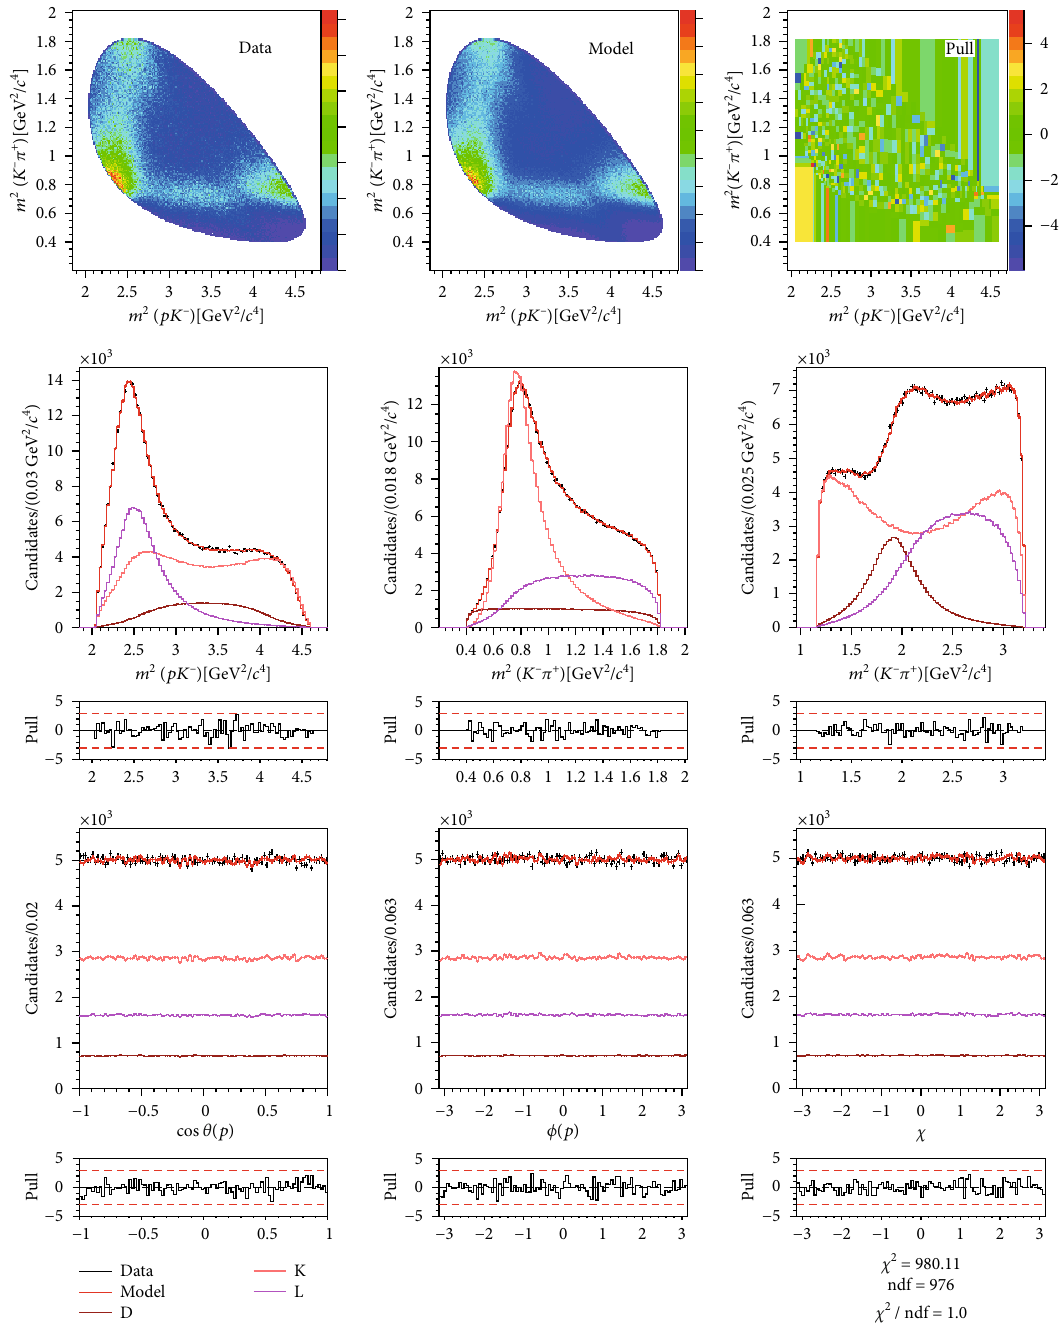
Figure 2: Comparison between Monte Carlo pseudodata ( “ Data ” ) and fi tted toy amplitude model ( “ Model ” ) projections for zero polarisation, summarized in Table